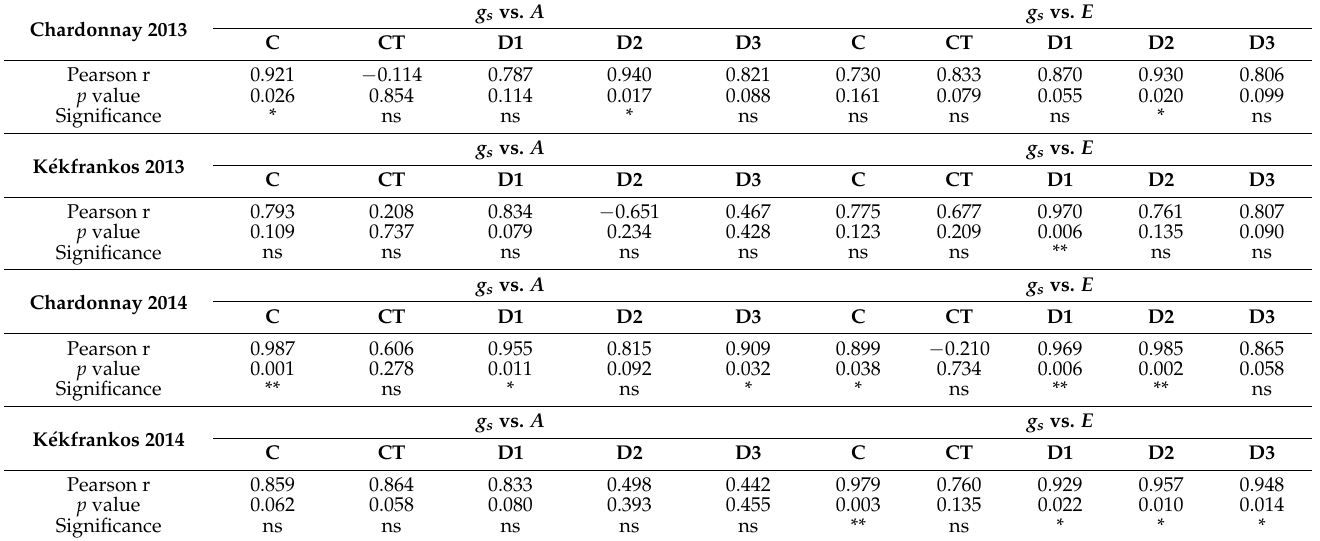
Table 1. Results of the correlation analysis between mean stomatal conductance ( g s ) and leaf as- similation rate ( A ) data or leaf transpiration rate ( E ) data in the case of each treatment, variety, and year, with 5-5 measurement dates/year. Asterisks mark the significance of differences (* p < 0.05, ** p < 0.005), ns: not